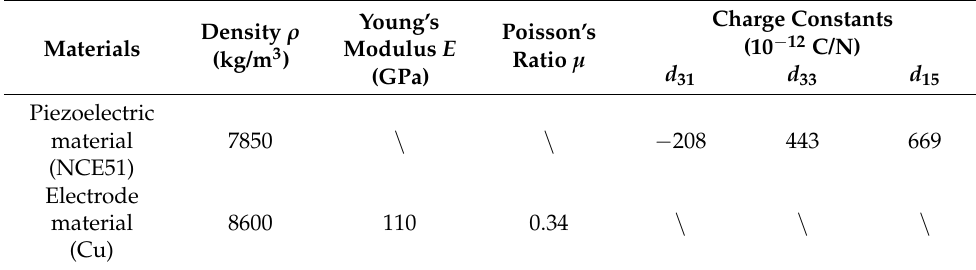
Table 1. The material parameters of the piezoelectric